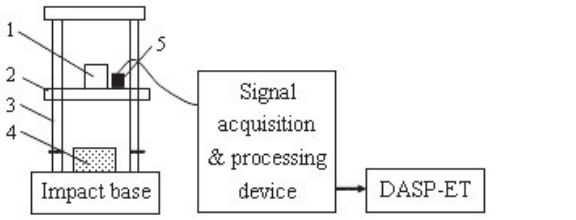
Fig. 2. Test system of dynamic shock cushioning characteristics. 1. Weight; 2. Dropping head; 3. Guide column; 4. Test specimen; 5. Acceleration